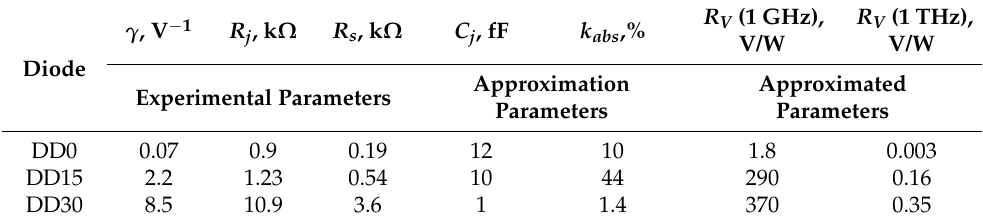
Table 6. Experimental and approximation parameters of the planar microwave